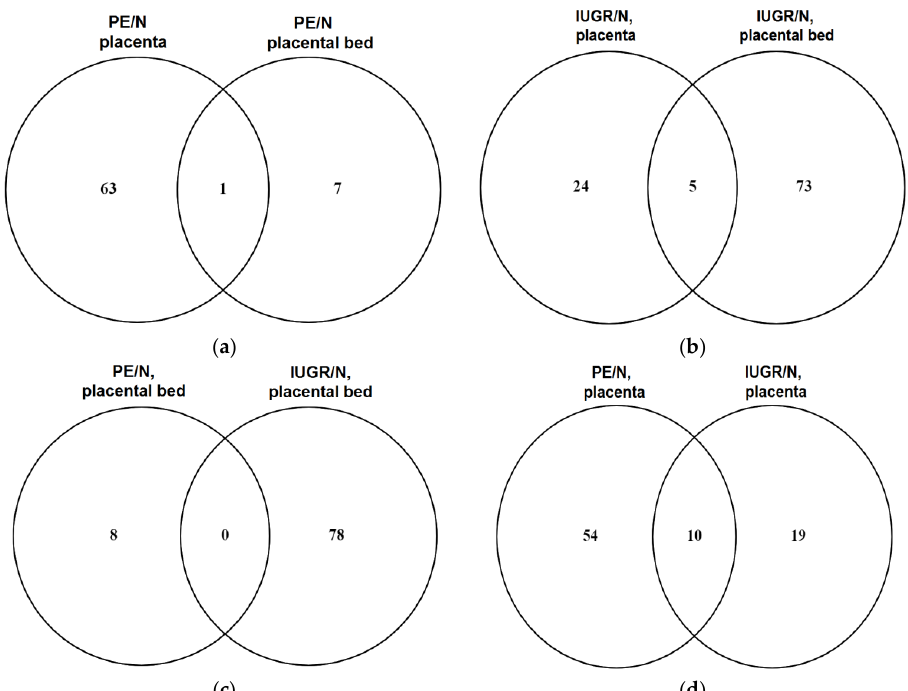
Figure 1. Venn diagrams. A comparison of the lists of differentially expressed miRNAs in ( a ) placenta vs. placenta bed samples from patients with PE < 34; ( b ) placenta vs. placenta bed samples from patients with IUGR < 34; ( c ) placental bed samples from patients with PE < 34 vs. IUGR < 34; ( d ) placenta samples from patients with PE < 34 vs. IUGR < 34.